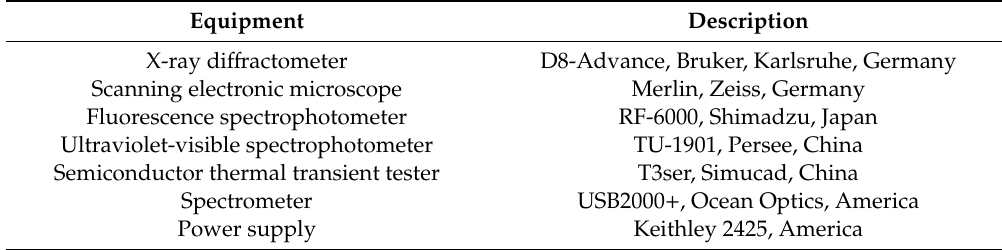
Table 1. The characteristics of